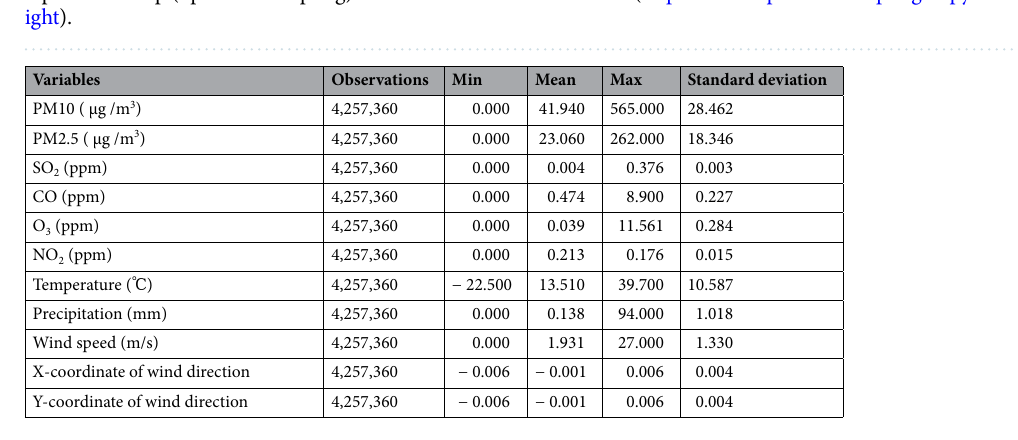
Table 1. Descriptive statistics of data after interpolation of missing data.